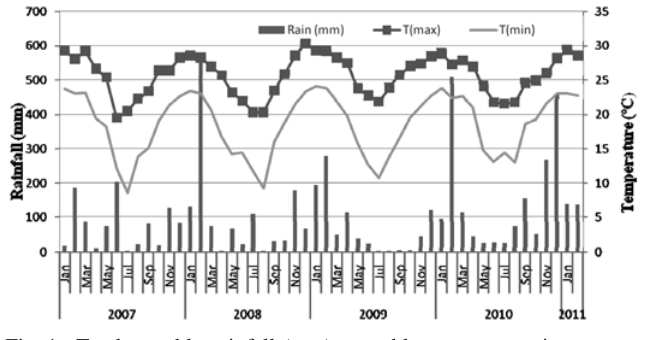
Fig. 1 - Total monthly rainfall (mm), monthly average maximum tem- perature (°C), and monthly minimum temperature (°C) over the experimental period at